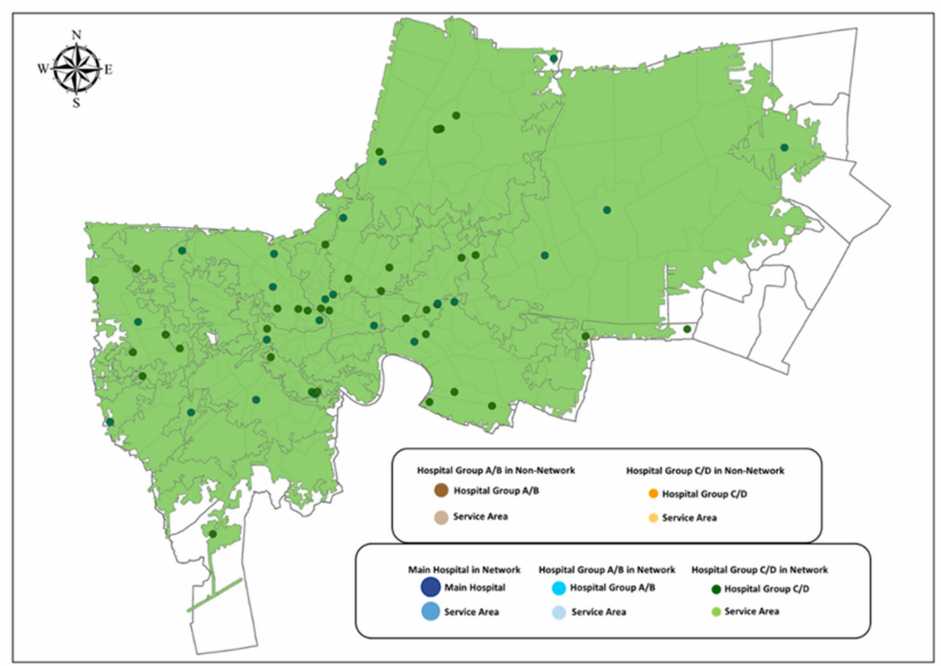
Figure 17. Service area if non-network hospitals in Group C/D were changed to network hospitals with patient transferal to the nearest Group A/B